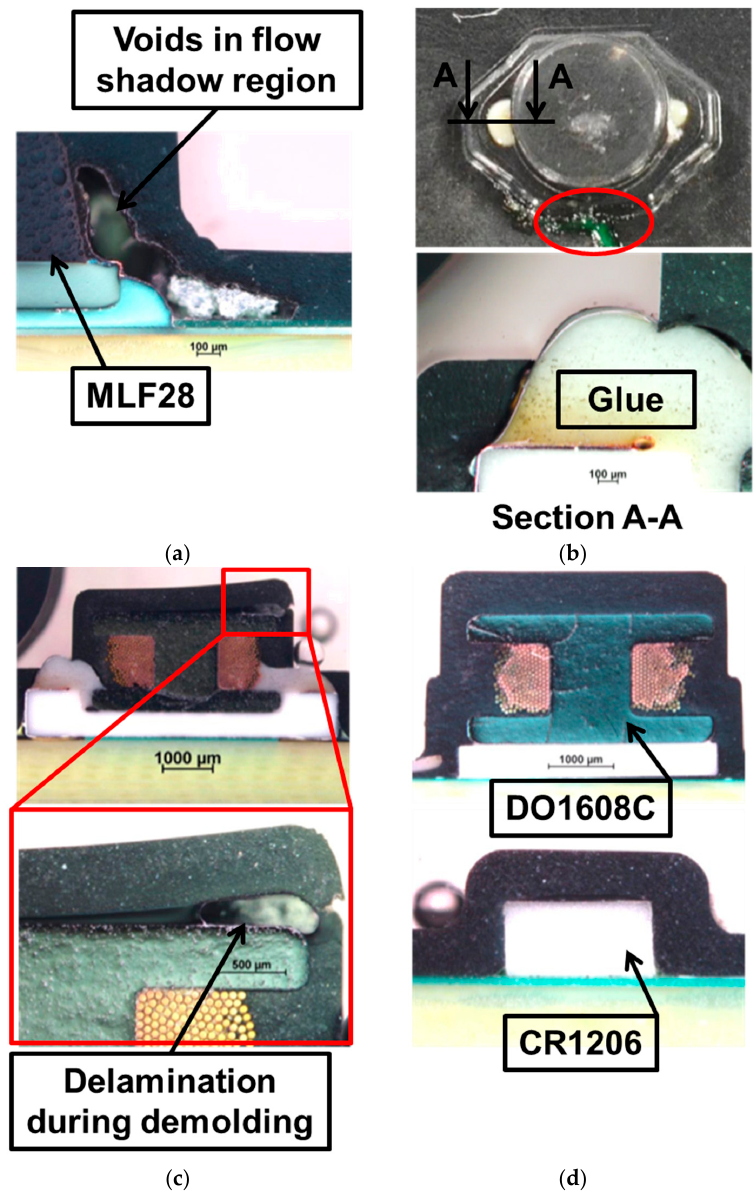
Figure 17. Results from microscopic analysis I. ( a ) Voids were noticed in the flow shadow region of the MLF. ( b ) An uncovered area (marked red) was noticed between two devices and the irregular shape of the glue around the induction coil caused irregularities. ( c ) Delamination of the encapsulation from the holder of the induction coil was noticed due to a lower thickness available in the lateral direction. ( d ) An offset is seen in the positioning of the induction coil and the resistor that enforced the presence of non-uniform encapsulation thicknesses on both sides of the